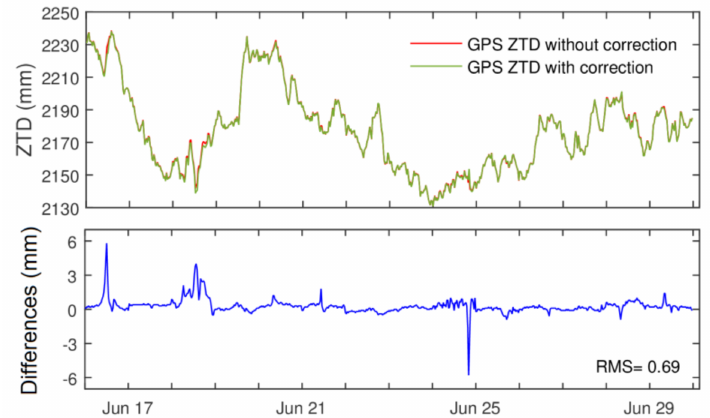
Figure 2. Time series of ZTD values ( top ) and di ff erences ( bottom ) at the DIYB GPS station on days 168–180 in